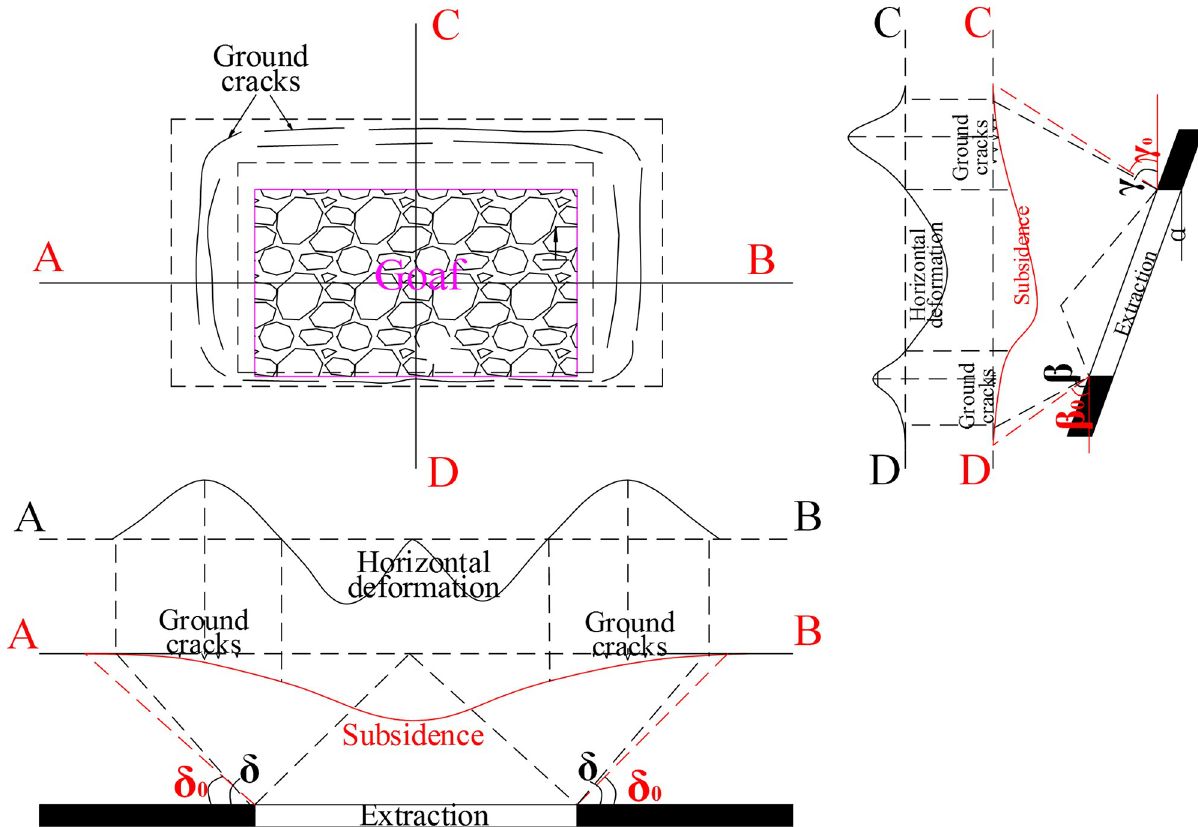
Fig 3. Schematic of ground surface deformation curve and boundary